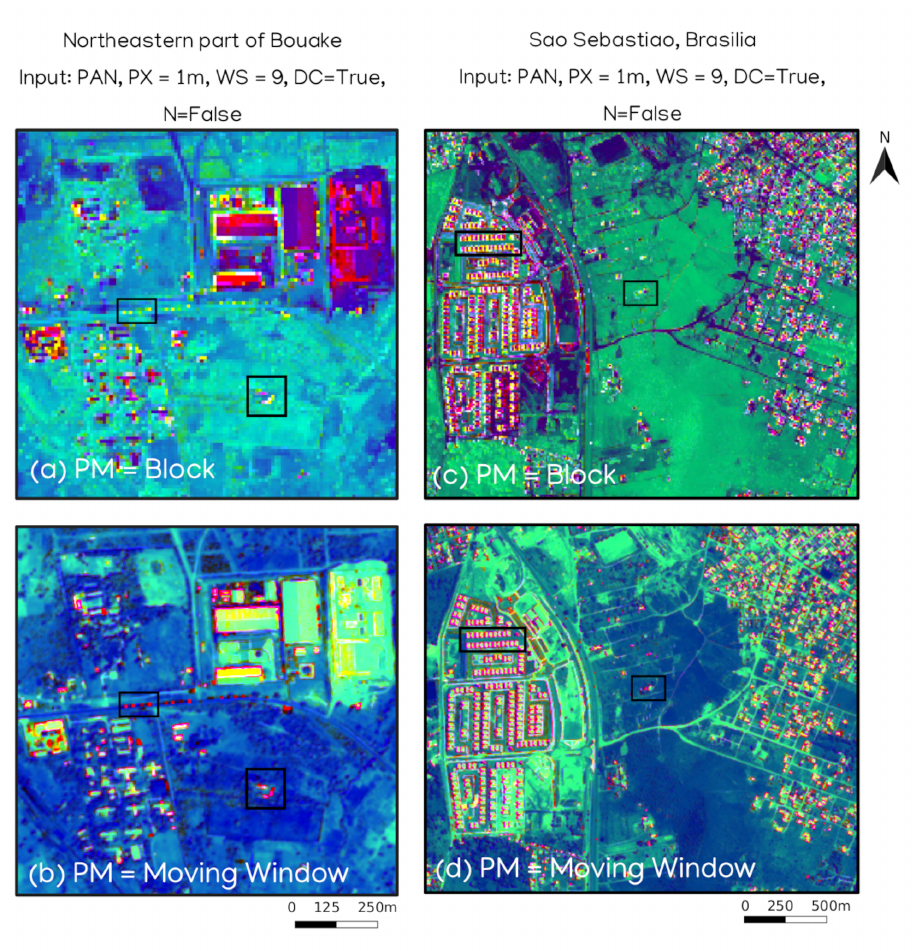
Figure 11. Influence of the partitioning method for the micro-scale characterization of urban objects on Bouake and Brasilia using Pleiades images ( a ) block method on Bouake, ( b ) block method on Brasilia, ( c ) moving window method on Bouake and ( d ) moving window method on Brasilia (PX = pixel size, WS = window size, PM = partitioning method, DC = DC component, N =